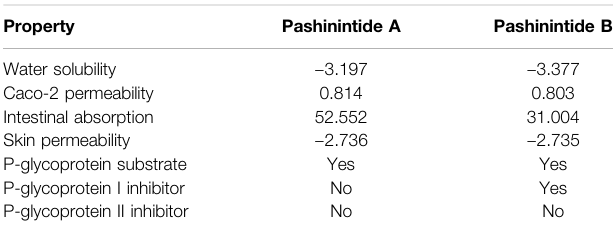
TABLE 5 | Distribution properties of the Pashinintides A and